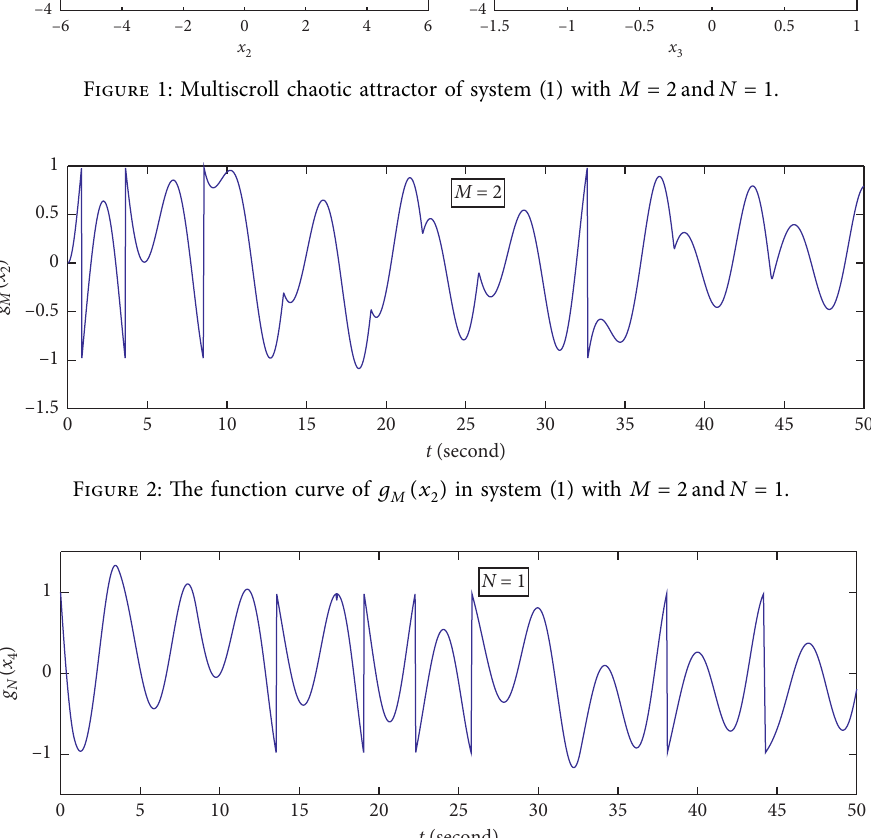
( x ) in system (1) with M � 2and N � N 4